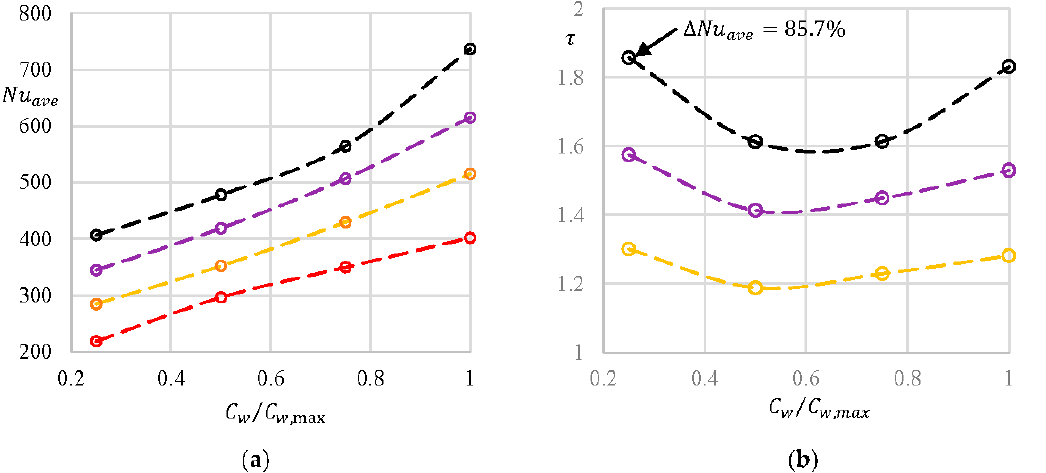
Figure 12. Comparison of the heat transfer performances: ( a ) Changes of Nu ave versus C w / C w ,max and ( b ) Variations of τ versus C w / C w ,max .